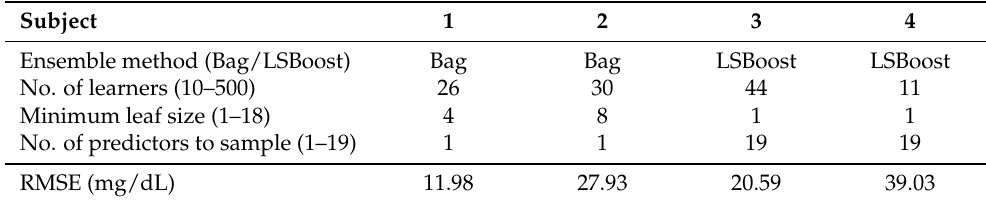
Figure 9. Percentage difference between the high and low glucose levels, based on the values of the ten most significant features across the four subjects. The % difference indicates the importance of a feature. Table 4. Optimal parameters of the ensemble regression models and the RMSE of the 5-fold cross- validation results.